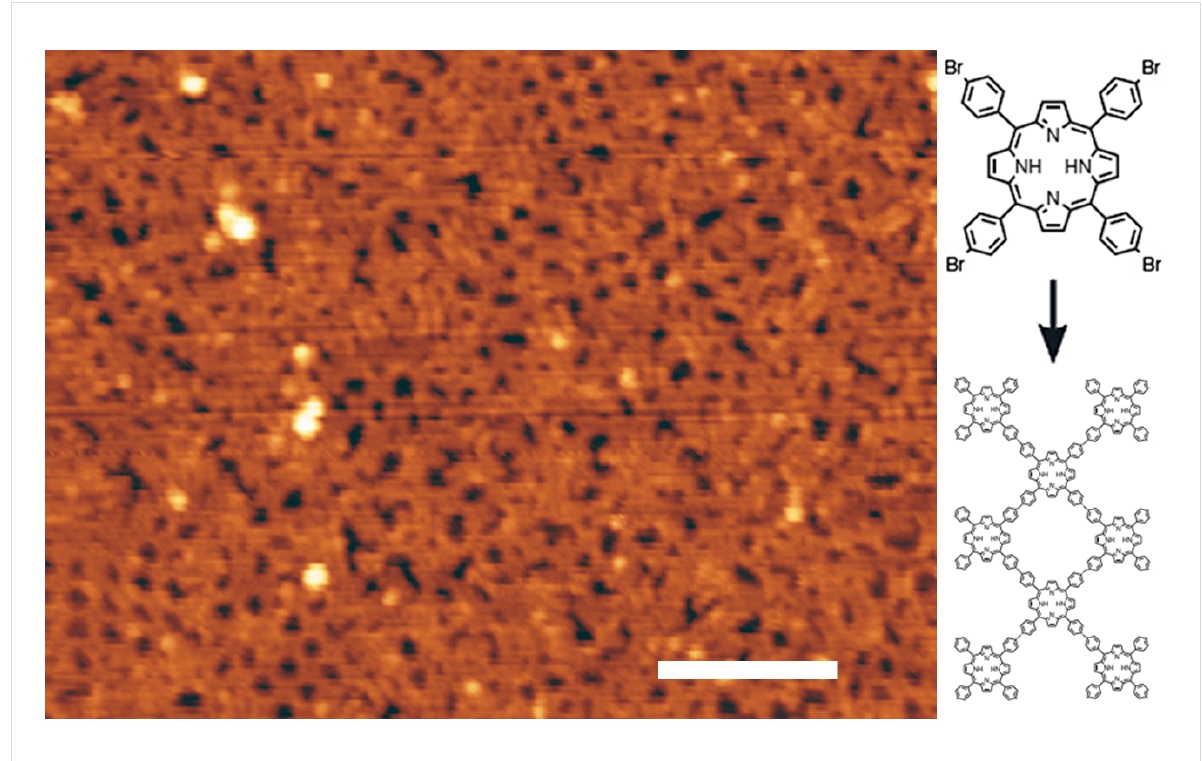
Figure 4: STM image of extended polymerized TBPP ( − 1.7 V, 0.03 nA, scale bar: 10 nm); schematic: structure of a TBPP monomer and the resulting polymeric structure.